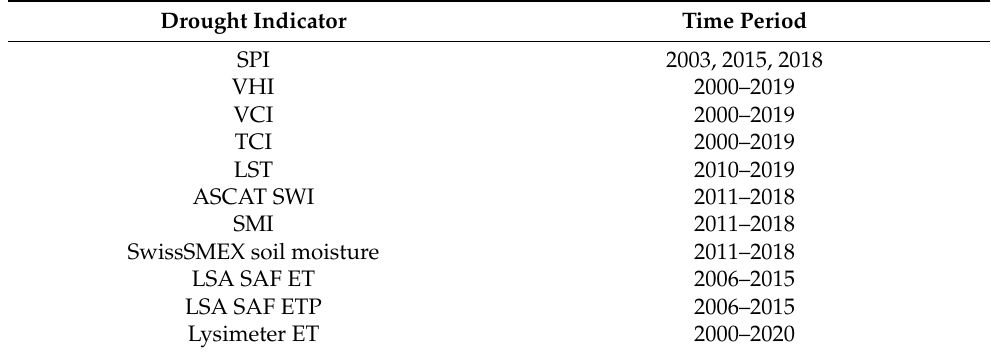
Table 1. Analyzed time periods for the considered drought